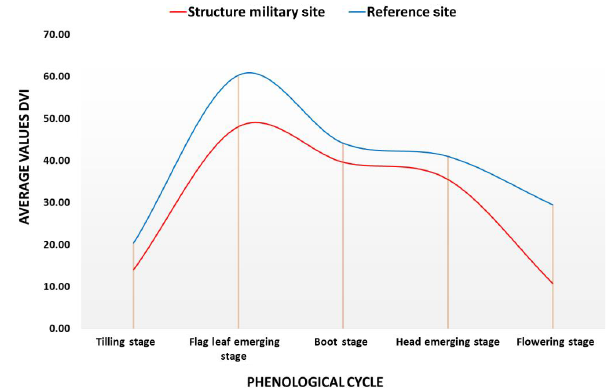
Table 6. Same as Table 3 but for the head emerging